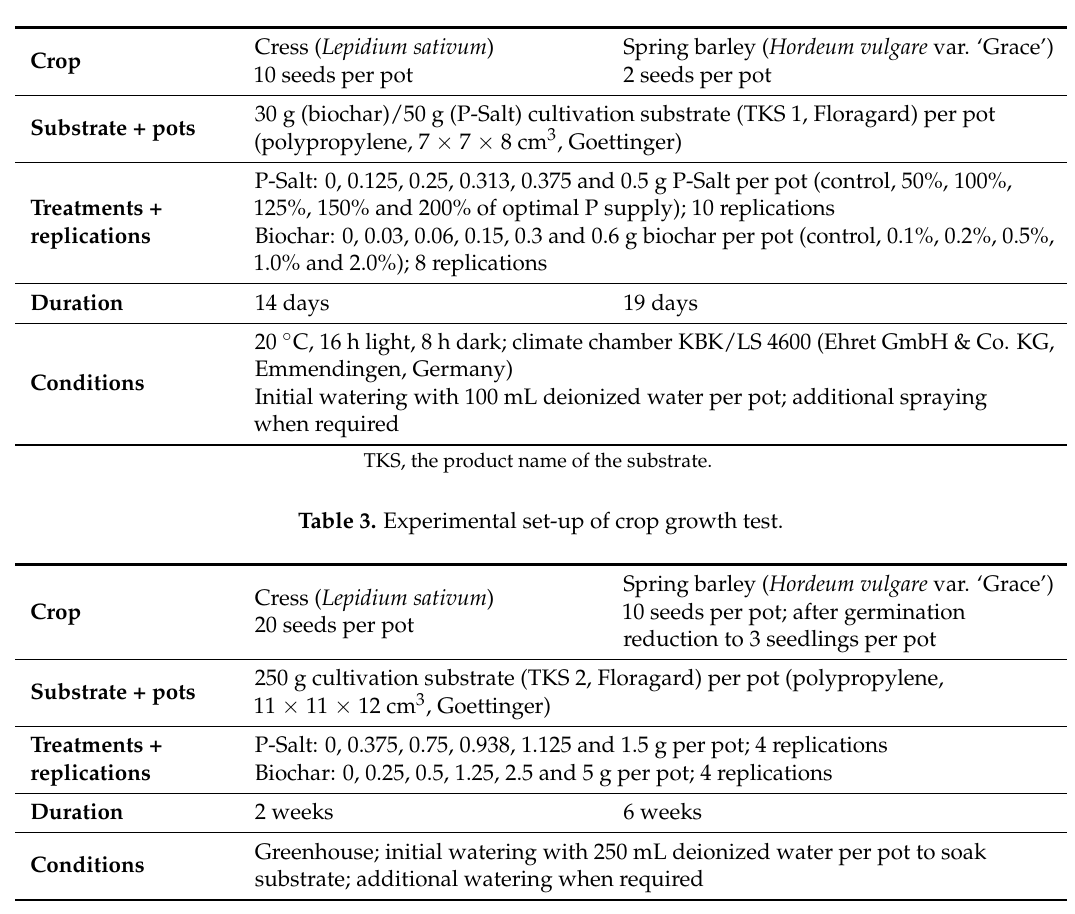
Table 2. Experimental set-up of seed germination test.